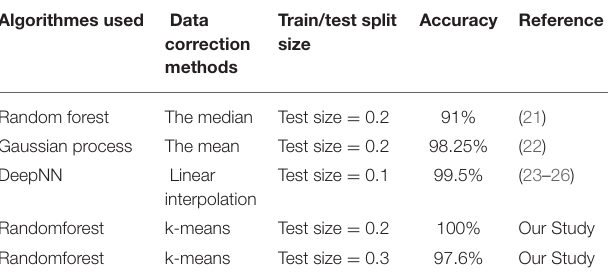
TABLE 6 | Comparison of the proposed work with the existing works (Frankfort Allemagne). Algorithmes